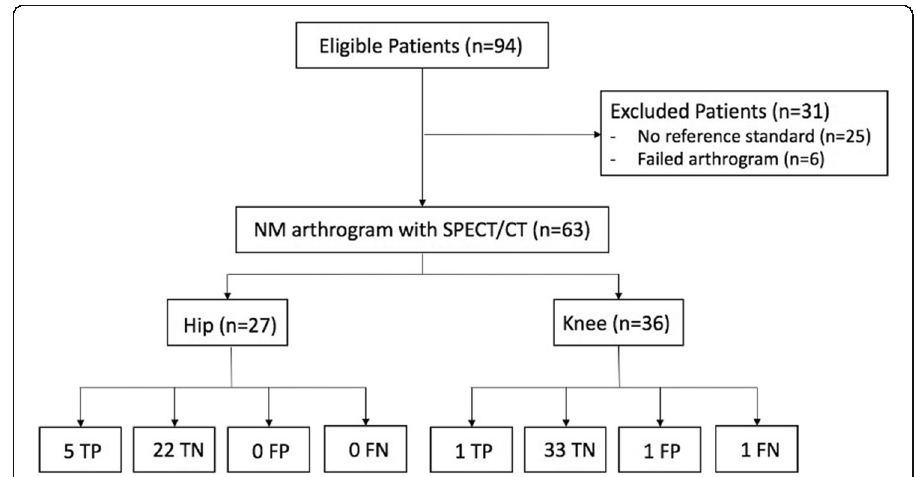
Fig. 1 Study participants. TP, true positive; TN, true negative; FP, false positive; FN, false